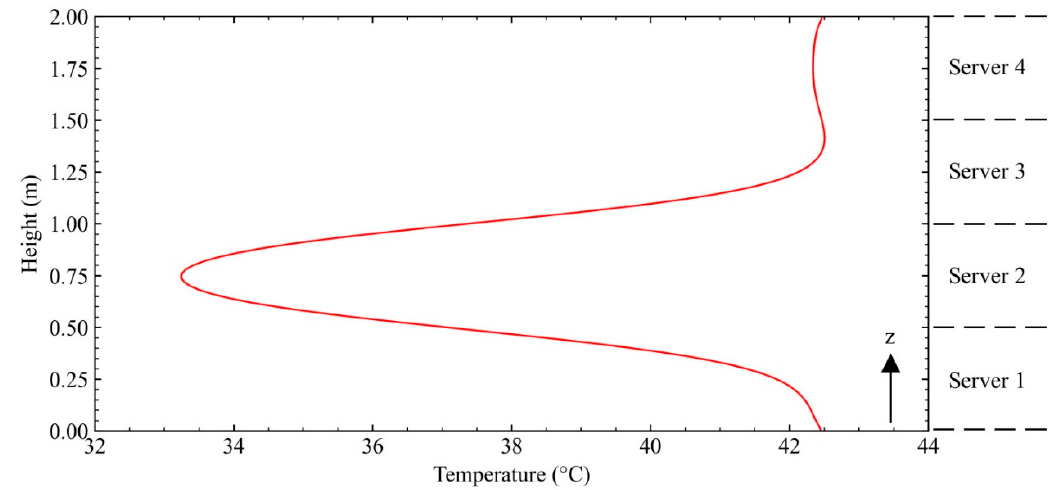
Figure 20. Distribution of the exhaust temperature of the rack.